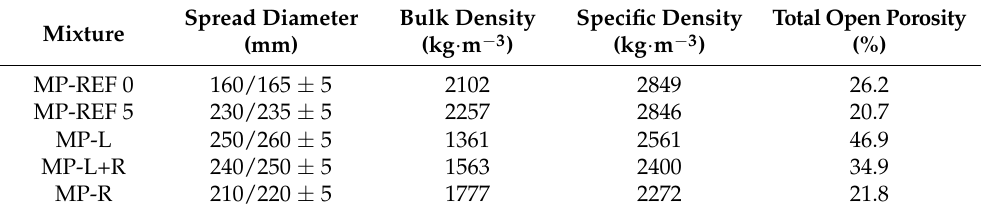
Table 8. Workability of fresh mortar mixtures and basic structural properties of the hardened mortars.